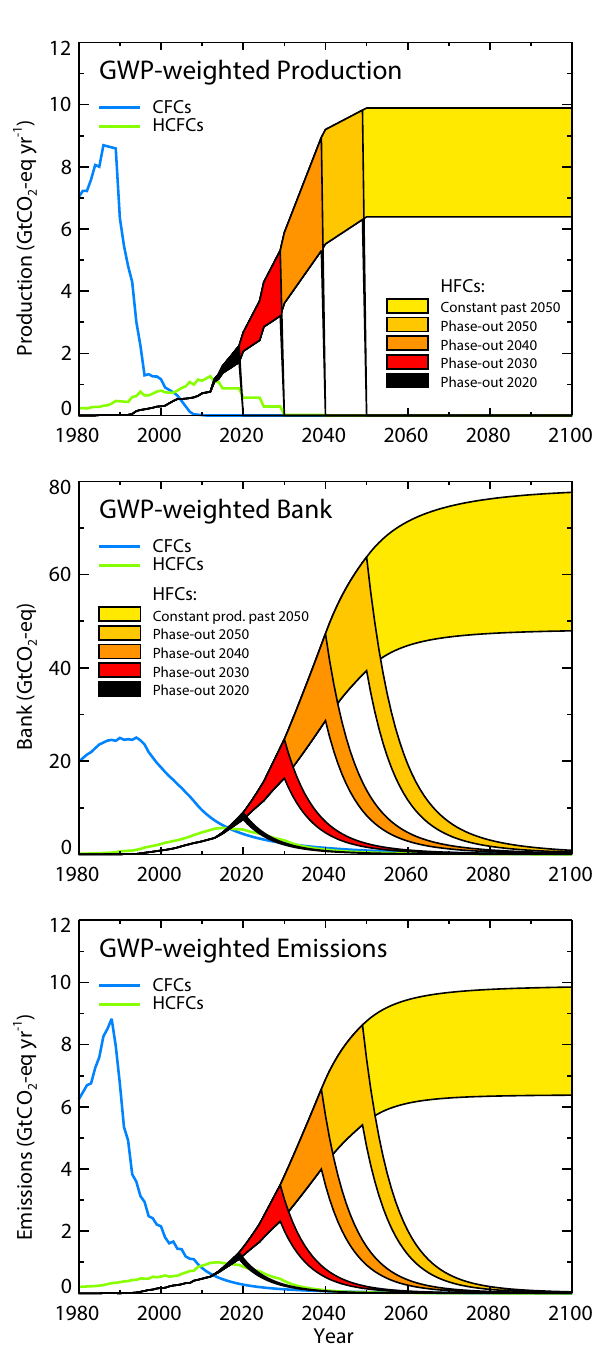
Fig. 2. GWP-weighted production, bank, and emissions of halocar- bons for the period 1980 to 2100. Calculated direct GWP-weighted data (100yr time horizon) are shown for the baseline scenarios of the CFCs and HCFCs (WMO, 2011) and the upper and lower ranges of the HFC scenarios from Velders et al. (2009). In these scenarios the HFC production past 2050 is constant at the 2050 level. Four ad- ditional scenarios are shown in which there is a global phaseout in production of HFCs in 2020, 2030, 2040, or 2050. The GWPs used here are those used in the reference scenarios, i.e., of WMO (2011) for the CFCs and HCFCs, and IPCC (2007) for the